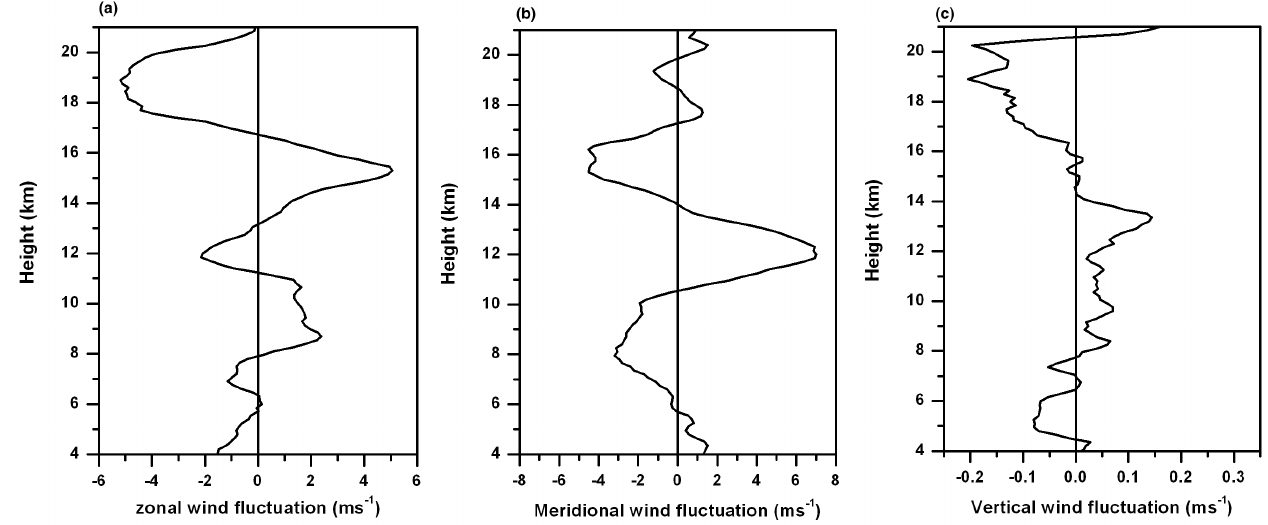
Fig. 3. Typical height profiles of (a) Zonal, (b) Meridional and (c) vertical wind fluctuations estimated by subtracting the second order polynomial as background.